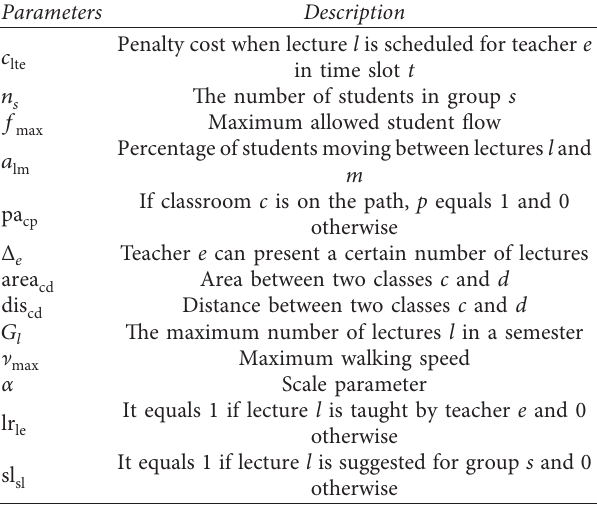
Table 3: Parameters of the model.